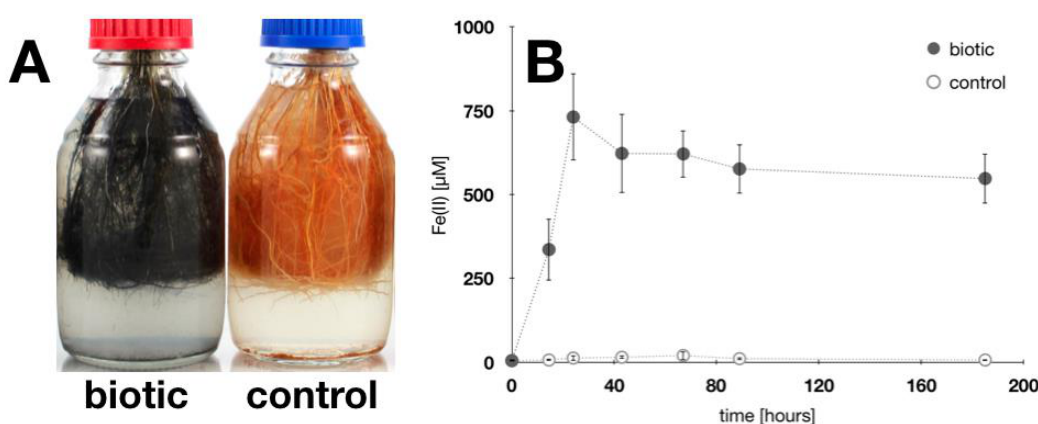
Figure 5. Root iron plaque reduction. ( A ): Root iron plaque exposed for 24 h to an Fe(III)-reducing enrichment culture (99.8% similarity to Geobacter spp.). Iron plaque minerals changed from orange (control) to black (biotic) during incubation. ( B ): Dissolved Fe(II) concentrations in medium during iron plaque reduction. Iron(III) plaque minerals were reduced and Fe(II) remobilized through microbial reductive dissolution. Error bars represent experimental standard deviation from six replicate setups.